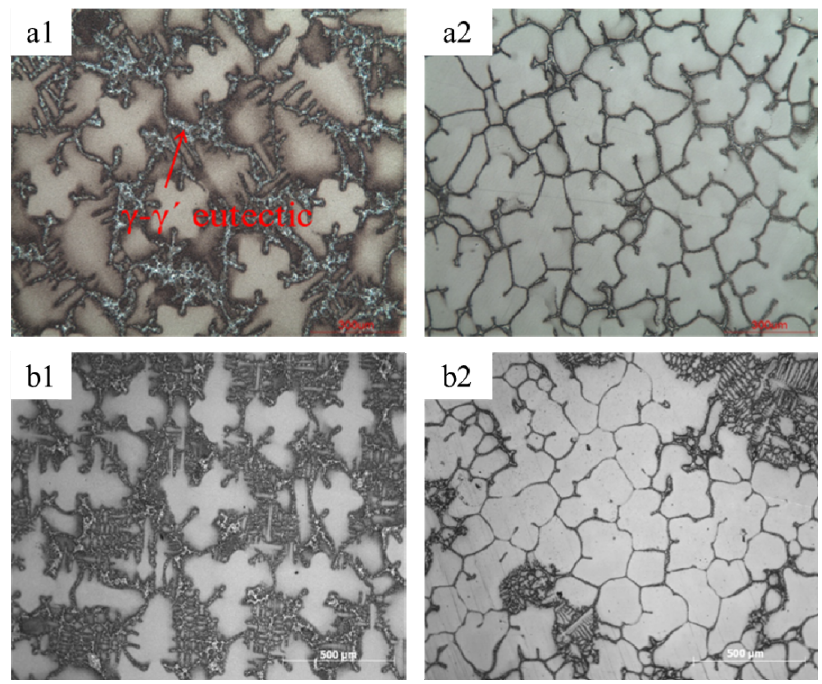
Figure 6. The morphology of γ - γ ’ of directionally solidified superalloy at a temperature gradient of 80 K·cm − 1 , drawing speed of 10 μ m·s − 1 : ( a1 ) 0 T, diameter of 4 mm; ( a2 ) 0.5 T, diameter of 4 mm; ( b1 ) 0 T, diameter of 12 mm; ( b2 ) 0.5 T, diameter of 12 mm.